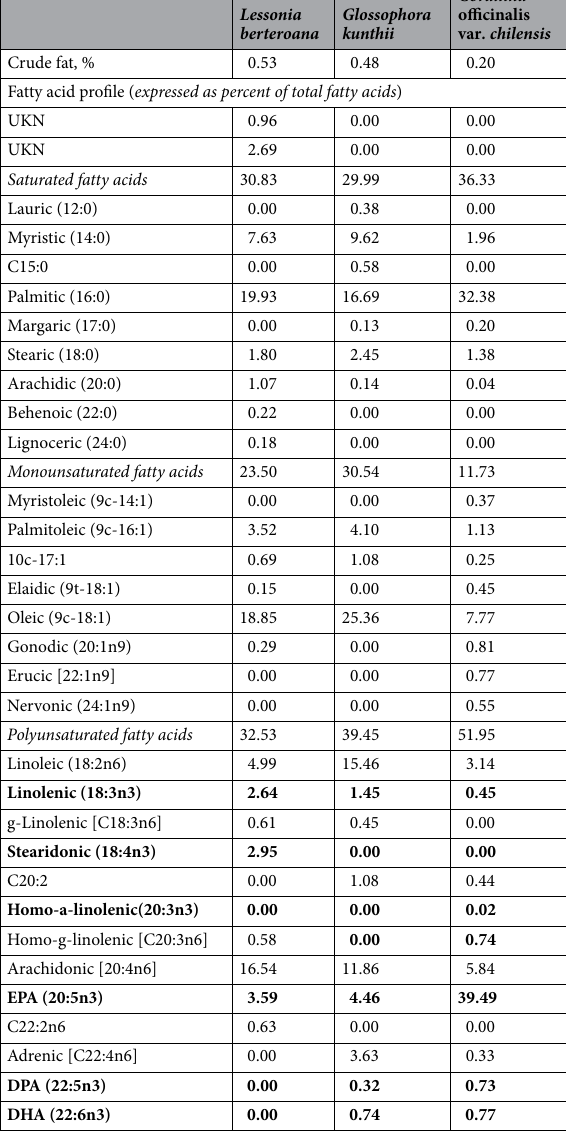
Table 4. Fatty acid profile of the main categories identified in the diet of adult Acha fish ( Medialuna ancietae ), n-3 fatty acid values are presented in bold. Results are expressed on a "dry matter"